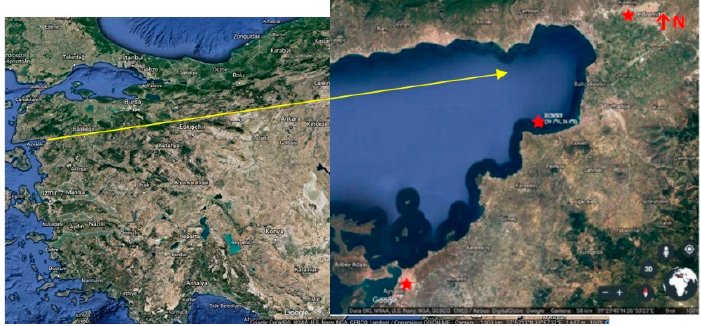
Figure 1. Geographical location of the study area in Edremit Bay [36].